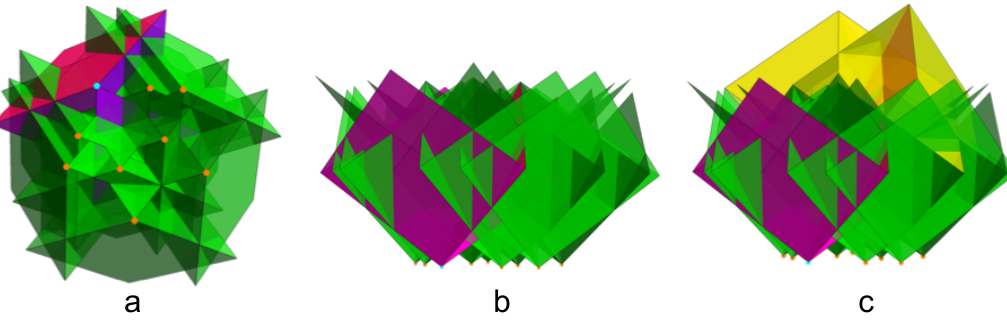
Figure 4. Representation of the neighbors in the perpendicular space. ( a ) The face-on view of the perpendicular space, where purple represents the K vertex patch, the green represents the nearest neighbors, the cyan point is the K vertex and the orange points are the eight neighbors’ vertices. ( b ) An edge-on view showing the tiles belonging to the K vertex patch and the tiles belonging to the nearest neighbors. ( c ) The same edge-on view, including this time, in yellow, the area corresponding to the neighbors that appear closer in the 2D projection, but are in fact further away in the perpendicular